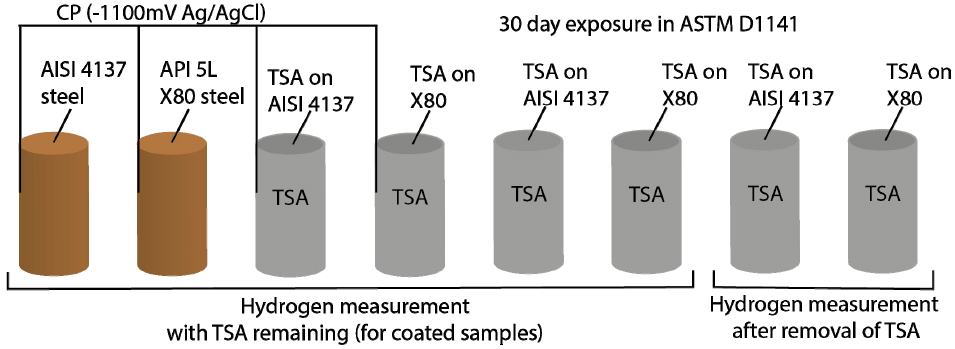
Figure 2. Schematic showing the experimental test matrix. A set of specimens had the TSA coating removed just before the hydrogen measurements.